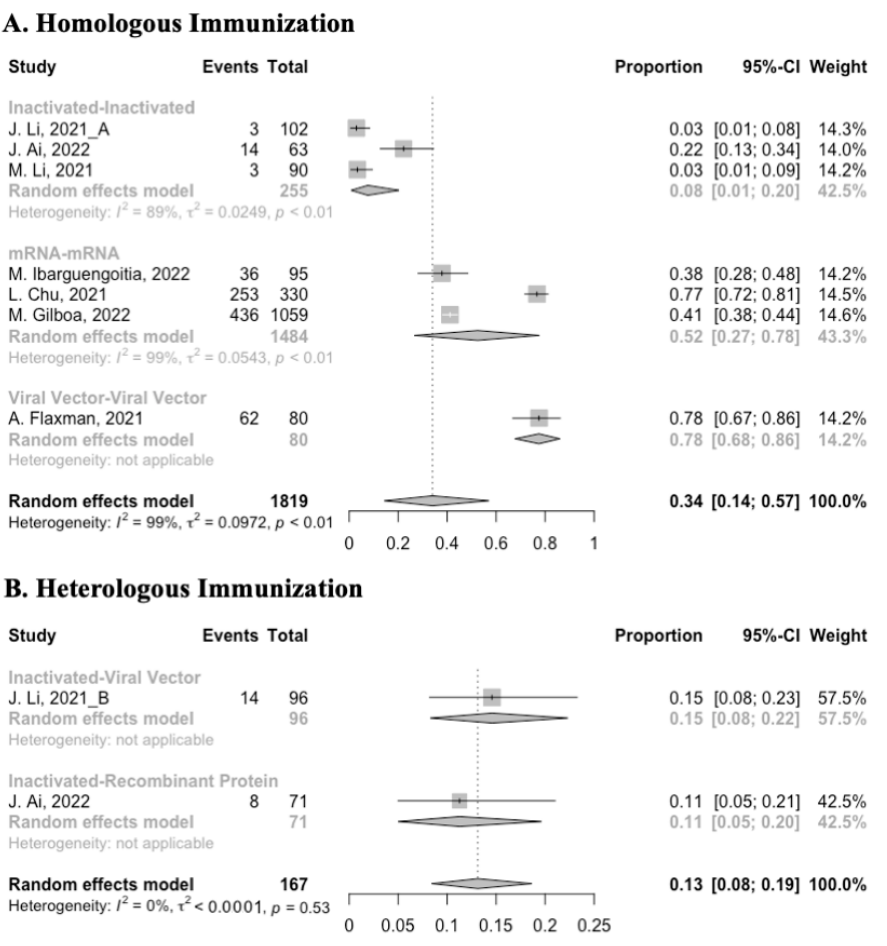
Figure 13. Forest plot of the overall incidence of systemic adverse events after booster vaccination.